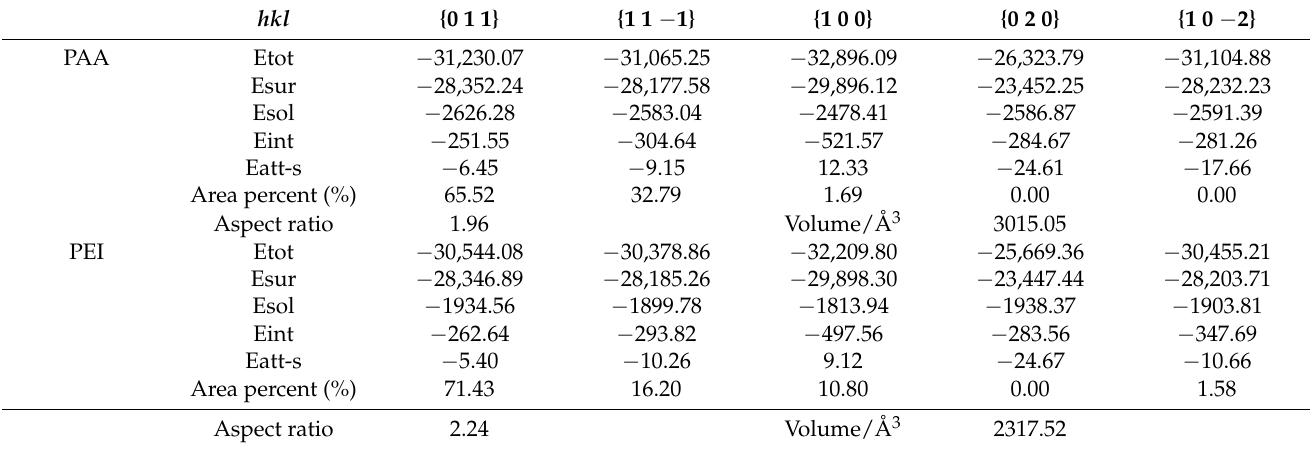
Table 6. Interaction energies and crystal habits of HMX in 10% additive at 298